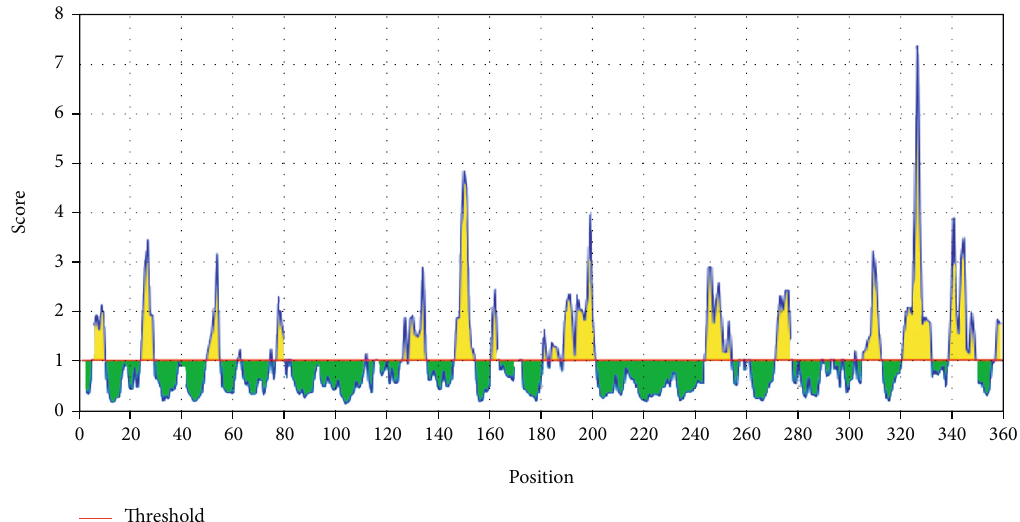
Figure 3: Emini ’ s surface accessibility prediction test: the red line is the threshold; above (the yellow part) is proposed to be part of the B-cell